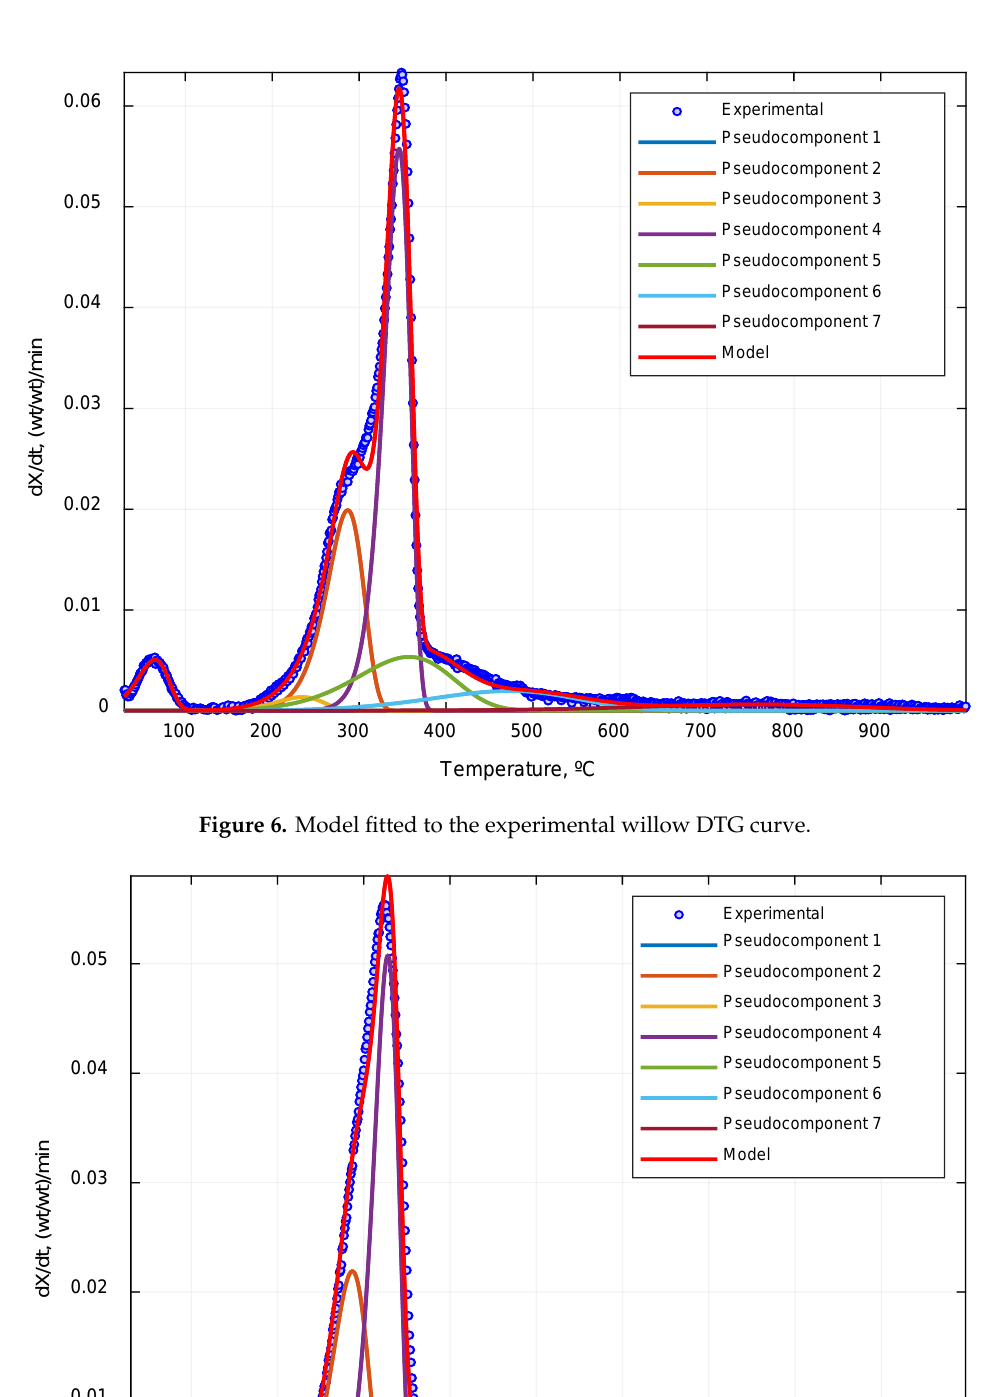
Figure 5. Model fitted to the experimental poplar DTG curve.